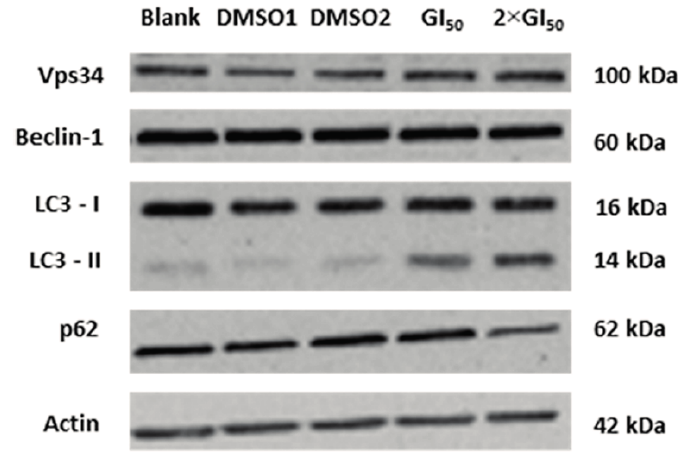
Figure 3. Analysis of the levels of the autophagy-related proteins Vps34, Beclin-1, LC3-I, LC3-II and p62, following treatment with G. lucidum methanolic extract, analyzed by Western blot. Cells were treated for 48 h with: medium only (Blank), with the methanolic extract (at GI 50 and 2 × GI 50 concentrations) or the corresponding volumes of the extract solvent (DMSO). Actin was used as loading control. Image is representative of three independent